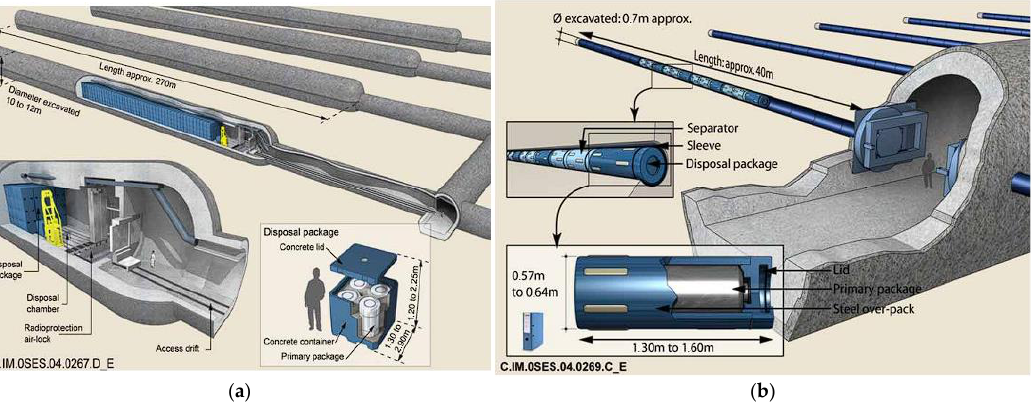
Figure 4. Illustration of containers with intermediate- ( a ) and high-level waste ( b ) and the order of their placement in the tunnels of the geological disposal facility Cigéo [38].